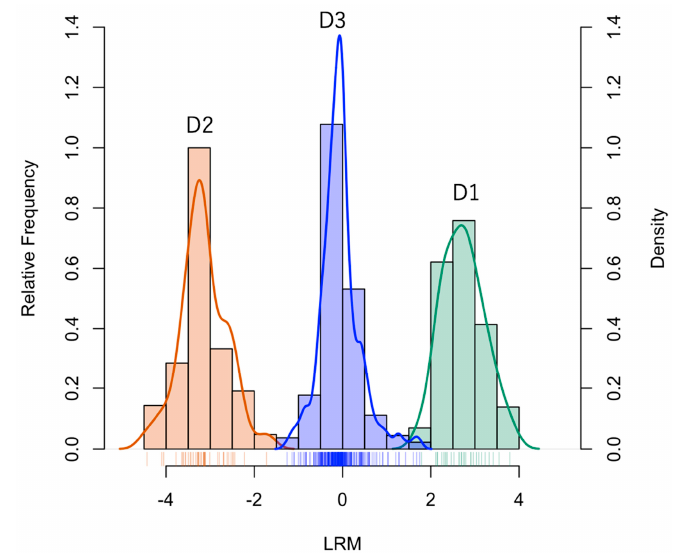
Figure 4. Normalized relative frequency histogram and kernel density estimation of D1 (compounds expressed only in Syneco; green histogram and line), D2 (compounds expressed only in Conv; orange histogram and line), and D3 (compounds expressed in both Syneco and Conv; blue histogram and line). The horizontal axis represents LRM: = log (mean intensity of Syneco/mean intensity of Conv). The vertical axes represent normalized relative frequency of the histograms (left) and estimated probability density (right). We projected the top 130 (65 positive and 65 negative) of PC3 loadings to KEGG BRITE (Table 2 and Figure 5) and KEGG PATHWAY (Table 3), and looked to the KEGG BRITE compound classification. The negative PC3 loadings that characterized Syneco samples expressed more diversity of allelochemicals than Conv samples such as phytochemicals, alkaloids, phenylpropanoids, and steroids. The “Phytochemicals” include the subcategories of alkaloids, flavonoids, phenylpropanoids, shikimate/acetate-malonate pathway derived compounds, terpenoids, polyketides, fatty acids related compounds, amino acid related compounds, and others, according to the notation in KEGG BRITE database.